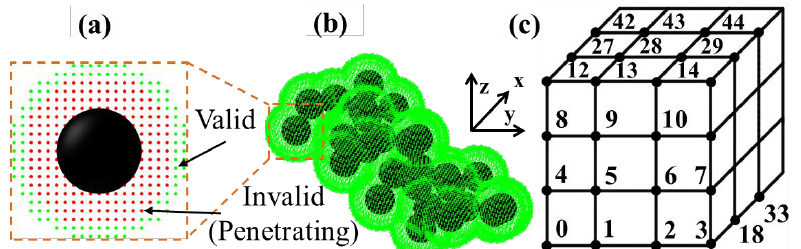
Figure 2. Simulated 3D CB structures of ( a ) an aggregate of fused carbon particles, ( b ) a primary particle with mapped valid (green) and invalid (red) placement indices, and ( c ) illustrated RVE with numbered indices.